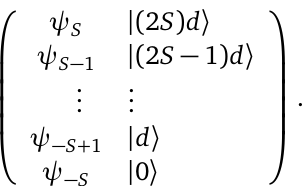
Figure 8: A few examples of eigenvalue spectra ˜ E of ˆ A 0 in (120) beyond the case S = 1 / 2 and d =